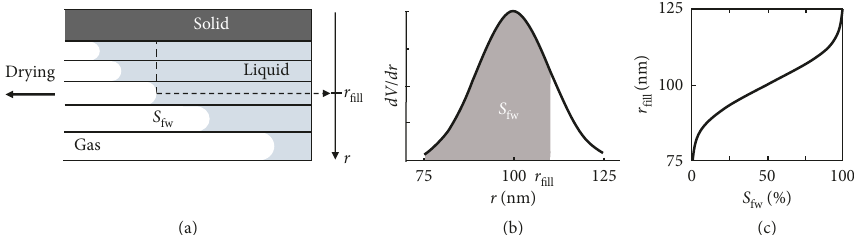
Figure 2: Partially saturated bundle of capillaries: relationship between free water saturation S